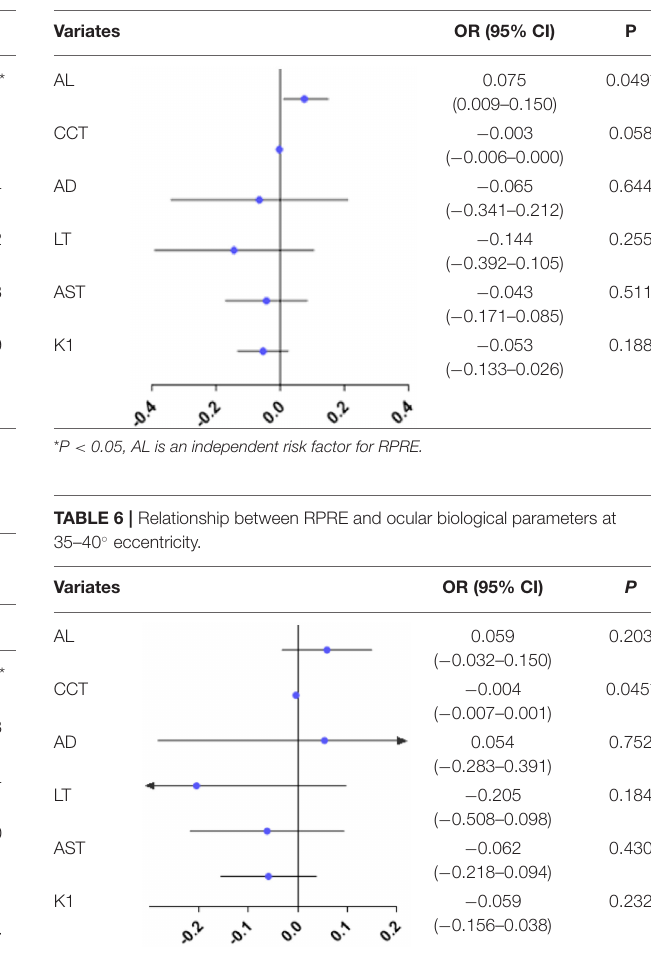
TABLE 3 | Relationship between RPRE and ocular biological parameters at 20–25 ◦ eccentricity.